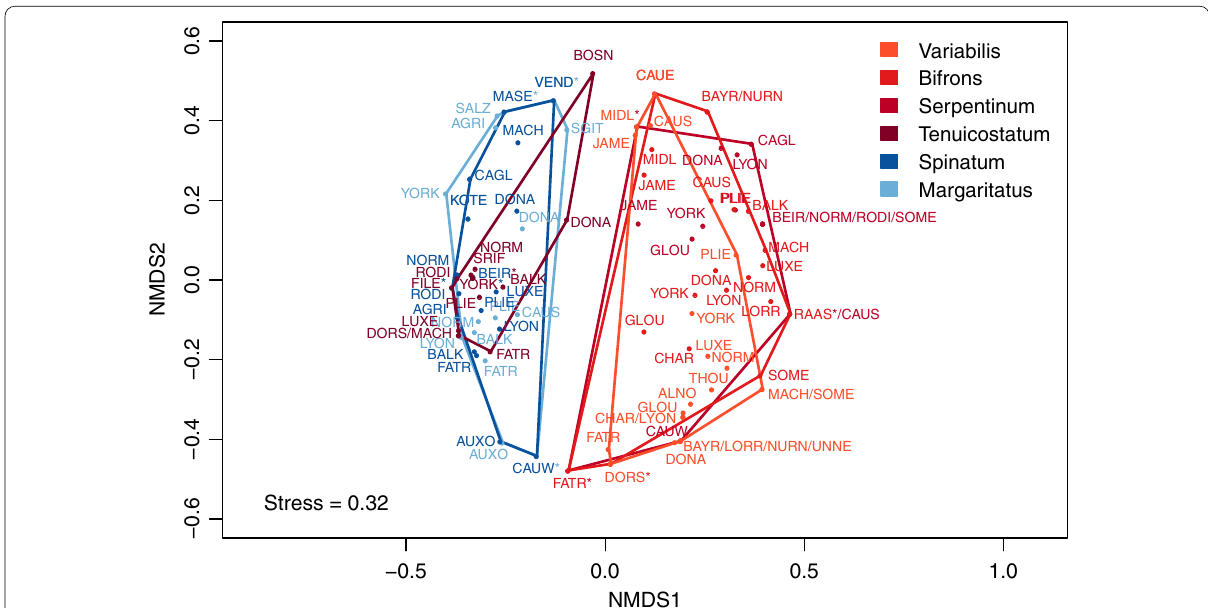
Fig. 3 NMDS analysis of species occurrences deriving from different basins and zones (dissimilarity metric (minimum stress value obtained after several